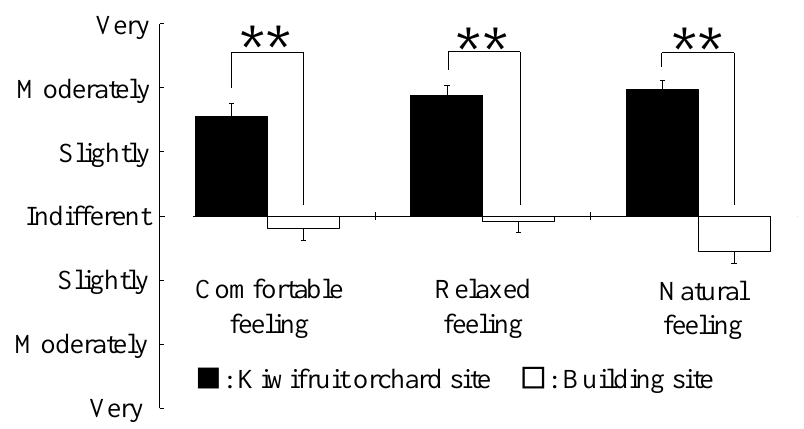
Figure 6. Comparison of the semantic differential questionnaire after 10-min viewing of a kiwifruit orchard or a building site. Data are expressed as the means ± SE; n = 17. ** p < 0.01 by the Wilcoxon signed-rank test (one-sided).